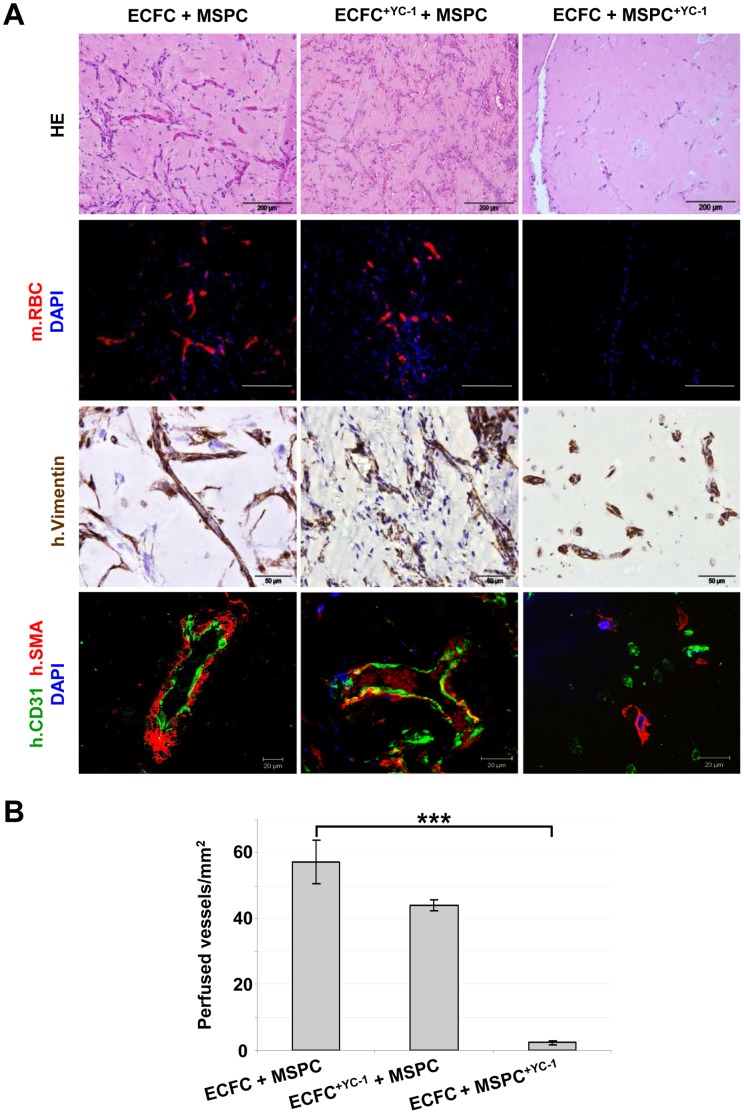
Human vessel formation after progenitor co-transplantation depends on hypoxia-induced factors in MSPCs but not ECFCs.(A) Vessel formation was determined 2 weeks after ECFC+MSPC (2×106 cells/300µL, ratio of 80∶20) co-transplantation. Pre-treatment of one of the two co-transplanted cell populations with YC-1 (1 h, 37°C; ECFC+YC1+MSPC, n = 3; ECFC + MSPC+YC1, n = 5) compared to untreated transplants (ECFC+MSPC, n = 8) as indicated above each column. Hematoxylin/eosin (HE) staining visualizes morphology (first row; scale bar 200 µm) and the mouse red blood cells (mRBC) resulting from perfusion after connection to the recipients’ circulation (Ter119 anti- mouse glycophorin reactivity, red; 4′,6-Diamidin-2-phenylindol, DAPI, blue; second row; scale bar 200 µm). Human mesodermal origin was visualized with anti-human vimentin monoclonal antibody staining (h.Vimentin, brown; mouse and human nuclei counterstained with hematoxylin, blue; third row; scale bar 50 µm). Plugs contain different numbers of h.Vimentin-negative infiltrating mouse CD45+ hematopoietic cells (see Figure S6C). Fourth row indicating presence or absence of human vessels stained with rabbit anti-human CD31 labeling ECFCs (h.CD31, green), mouse anti-human alpha smooth muscle actin labeling pericytes and mural smooth muscle cells (h.SMA, red) and nuclear counter-stain (DAPI, blue; scale bar 20 µm). (B) Microvessel density was quantified in 200x magnifications of HE stained Matrigel plug sections by ImageJ and counting red blood cell-filled vessel structures. A significantly decreased capacity to form perfused vessels was found in implants containing YC-1 pre-treated MSPCs compared to untreated co-transplants. (n = 3, 5 high power fields 200x; ***p<0.0001).